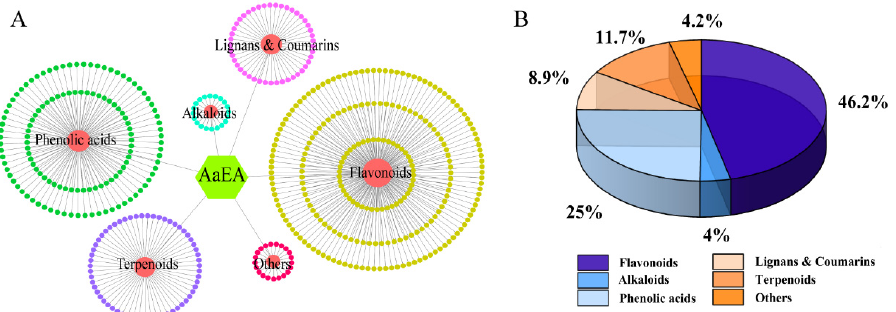
Figure 2. The types of compounds and their proportion in all compounds from AaEA. As shown in the diagram, the dark yellow spots stand for 233 flavonoids from AaEA, while green, purple, pink, blue, and red spots stand for 126 phenolic acids, 59 terpenoids, 45 lignans and coumarins, 20 alkaloids, and 21 others, respectively ( A ). The proportion of different component types ( B ).